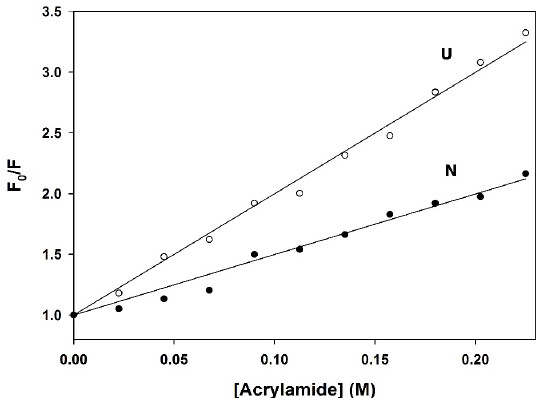
Figure 7. Stern–Volmer plots of F 0 / F versus quencher concentration for the native state (N) of PemA in 0.4 M GdmCl ( ● ) and the unfolded state (U) in 4 M GdmCl ( ○ ). F 0 and F are the fluorescence intensities in the absence and presence of acrylamide, respectively. Values of the average Stern–Volmer constant ( K SV ), i.e., 5.0 ± 0.1 M − 1 (N) and 10.0 ± 0.2 M − 1 (U), are given by the slope of the straight line fitted to the data according to Equation (1).